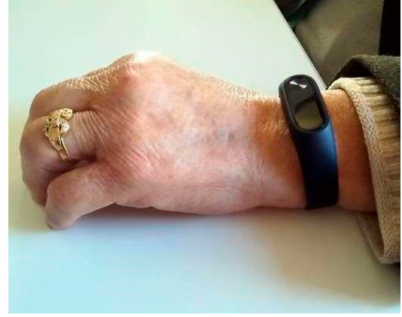
Figure 16. Elderly person wearing a